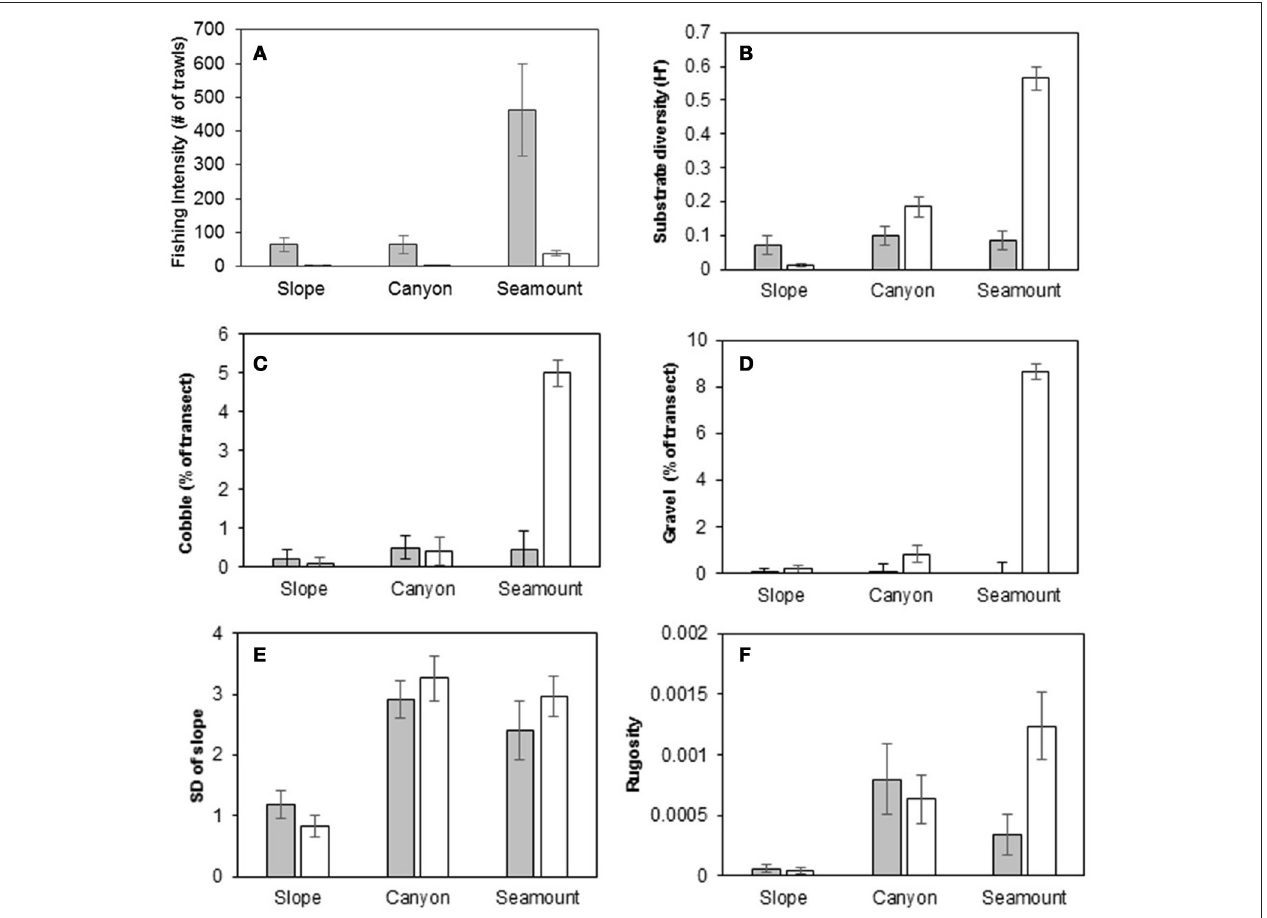
FIGURE 3 | Fishing intensity and physical characteristics of canyon, slope, and seamount habitats at the Hikurangi Margin (shaded bars) and Bay of Plenty (open bars) regions. (A) Fishing intensity, (B) Substrate diversity, (C) Cobble, (D) Gravel, (E) Standard deviation of slope, (F) Seafloor rugosity. Error bars are standard